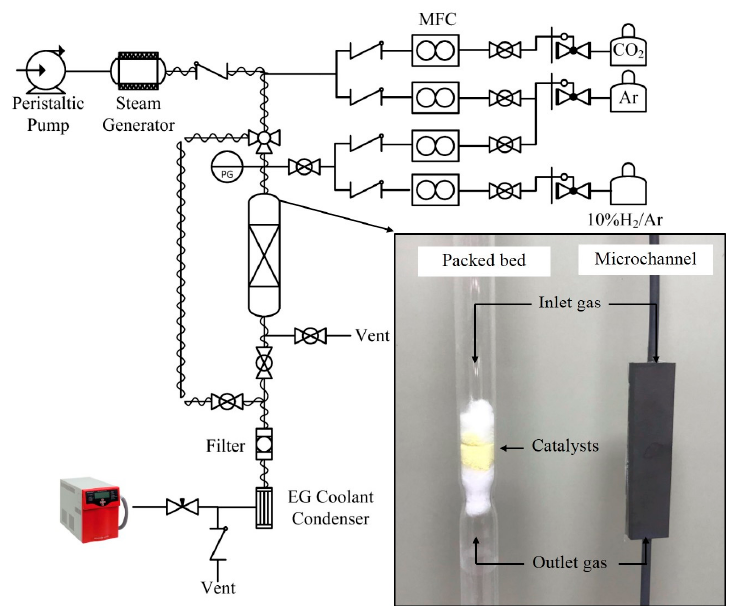
Figure 2. Rig schematic diagram for packed-bed and micro-channel process.